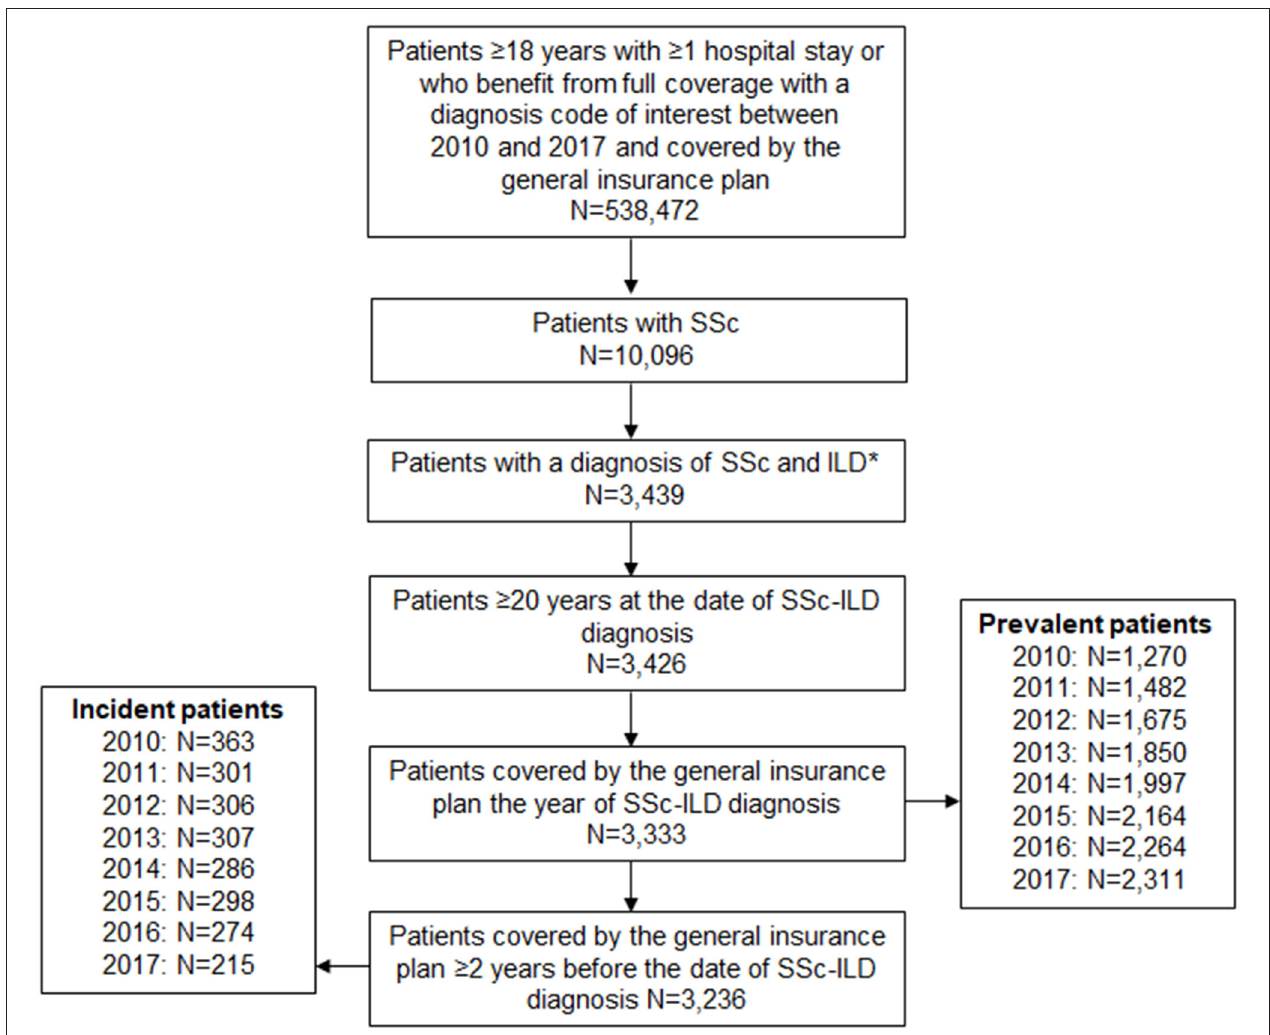
FIGURE 1 | Patient selection. *An eligible adult SSc-ILD patient was defined as a patient with either ≥ 1 hospital stay with a diagnosis code (principal, related or associated) of lung fibrosis, or ≥ 1 hospital stay with a diagnosis code (principal, related or associated) of SSc and/or a patient who benefited from full coverage for SSc (patients fully reimbursed for their claims related to SSc). ILD diagnosis could be made after, or within 6 months prior to, SSc diagnosis. ILD, interstitial lung disease; SNDS, Système National des Données de Santé; SSc, systemic